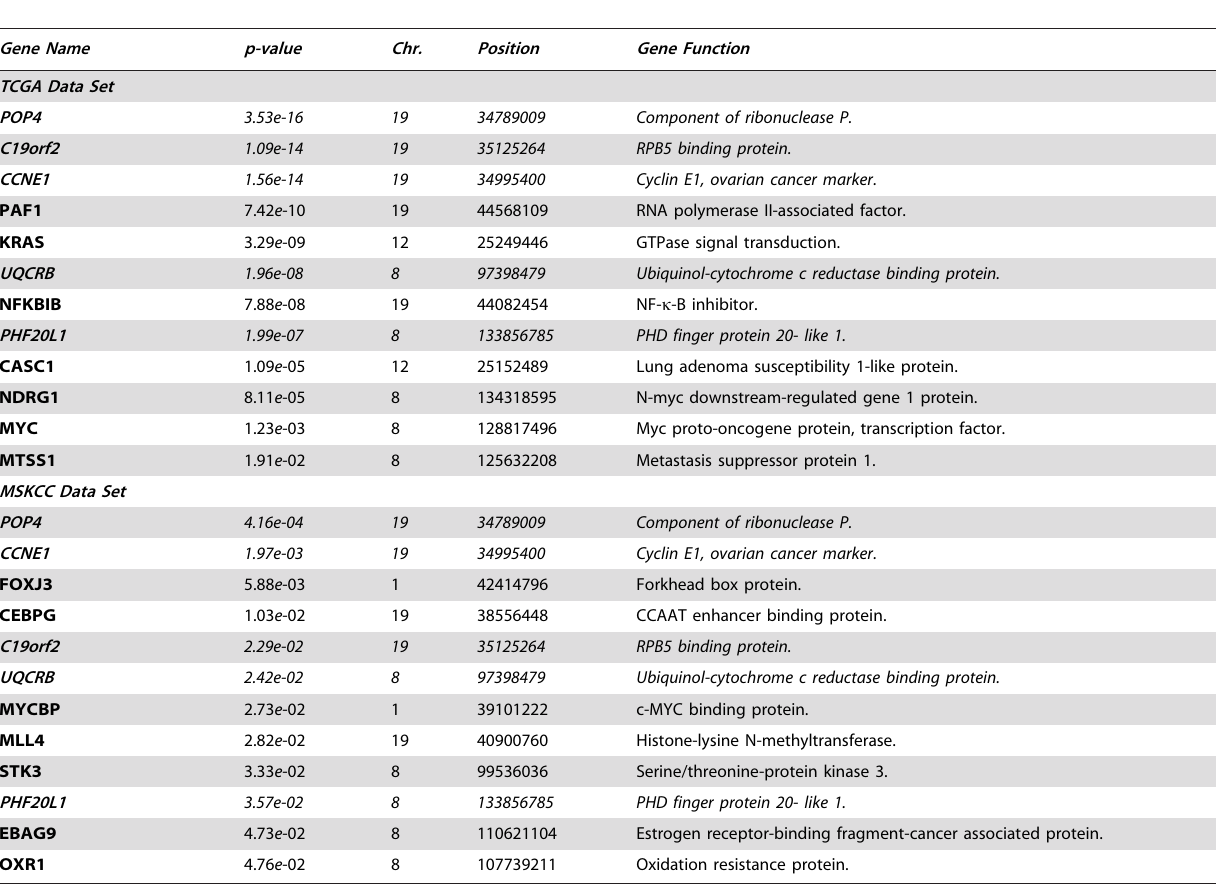
Table 2. Selected ovarian cancer genes captured by Wilcoxon rank test based on copy number variation and expression data * .